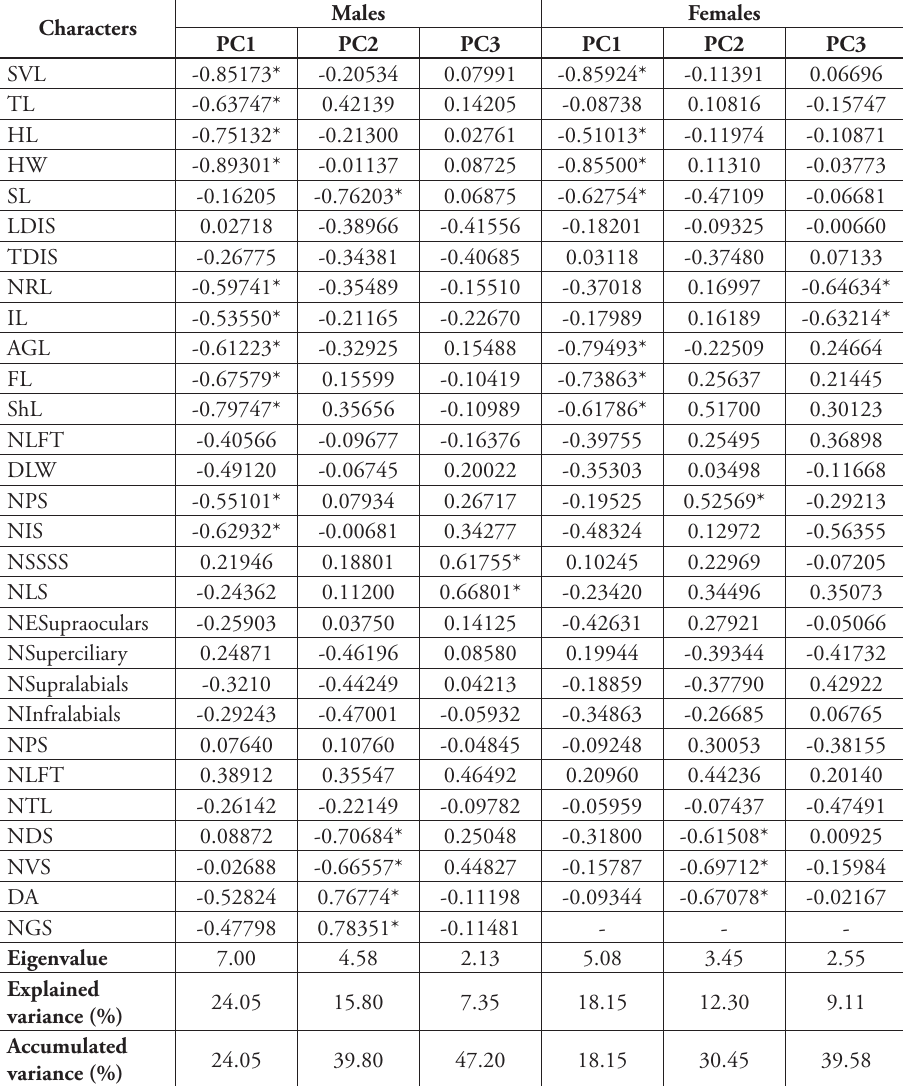
Table 1. Statistics from the PCA for males and females. Correlation coefficients among characters for the first three principal components. * Characters that explained the highest percentage of variation for each component. Also shown here are the eigenvalue, explained variance, and accumulated explained variance for the first three